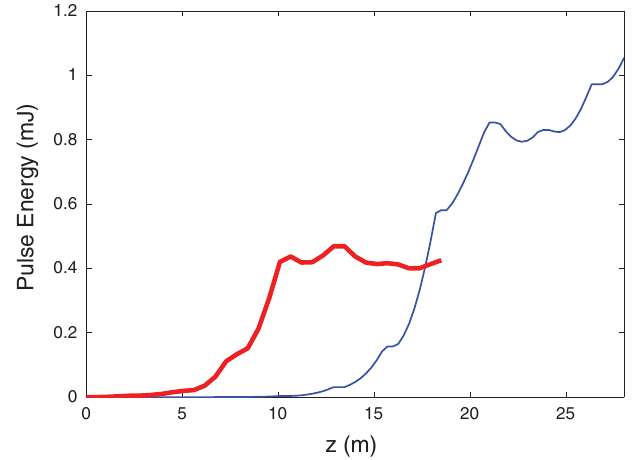
FIG. 11. (Color) Start-to-end pulse energy along the second undulator for the self-seeding (blue line) and for the HGHG (red thick line). The results for the self-seeding are averaged over 50 independent simulations. Pulse energy at saturation is (cid:3) 0 : 9 mJ for the self-seeding and (cid:3) 0 : 4 mJ for the HGHG.